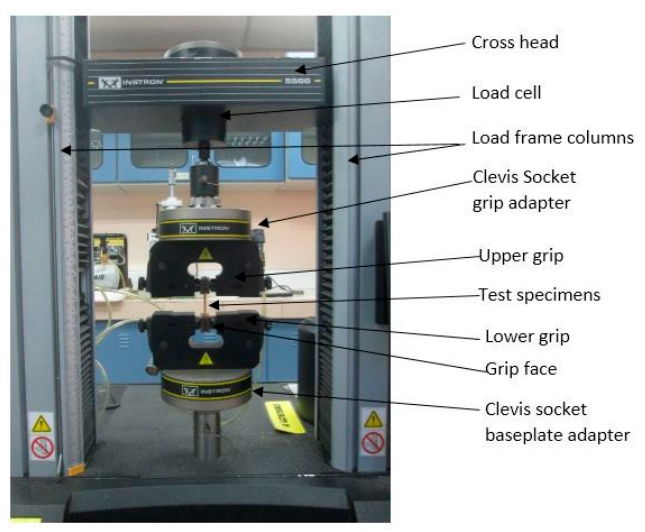
Figure 2. Tensile test setup.